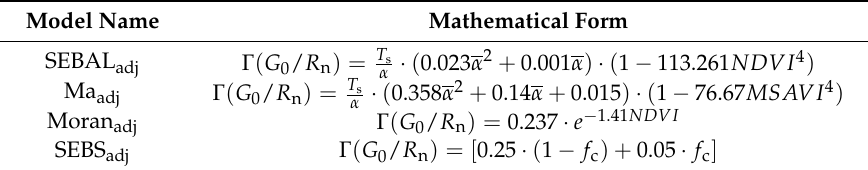
Table 4. Adjusted Remote Sensing Model of Estimating Γ ( G 0 / R n